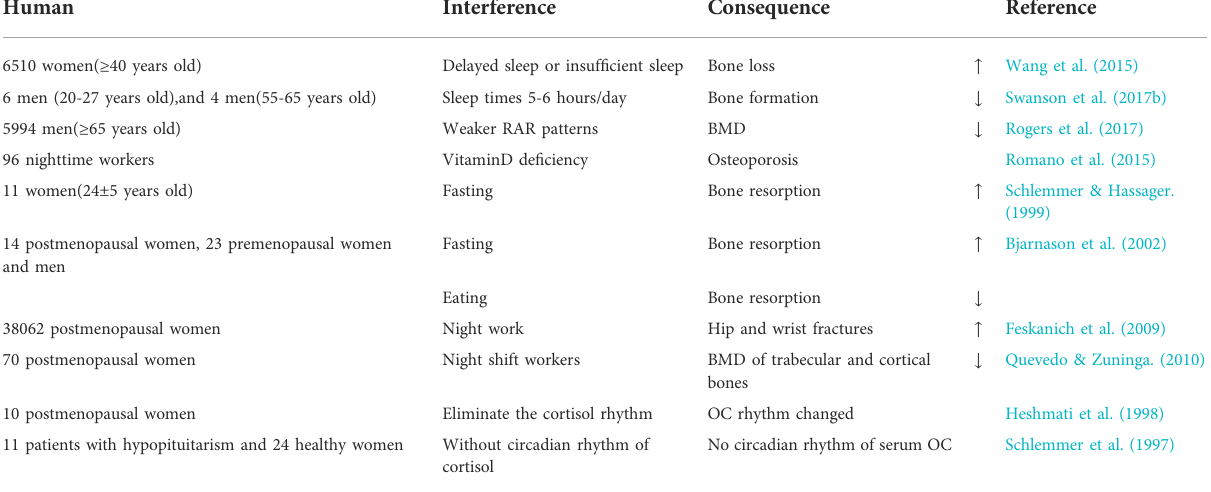
TABLE 6 Biological rhythm disorders in bone tissue lead to osteoporosis in human studies.